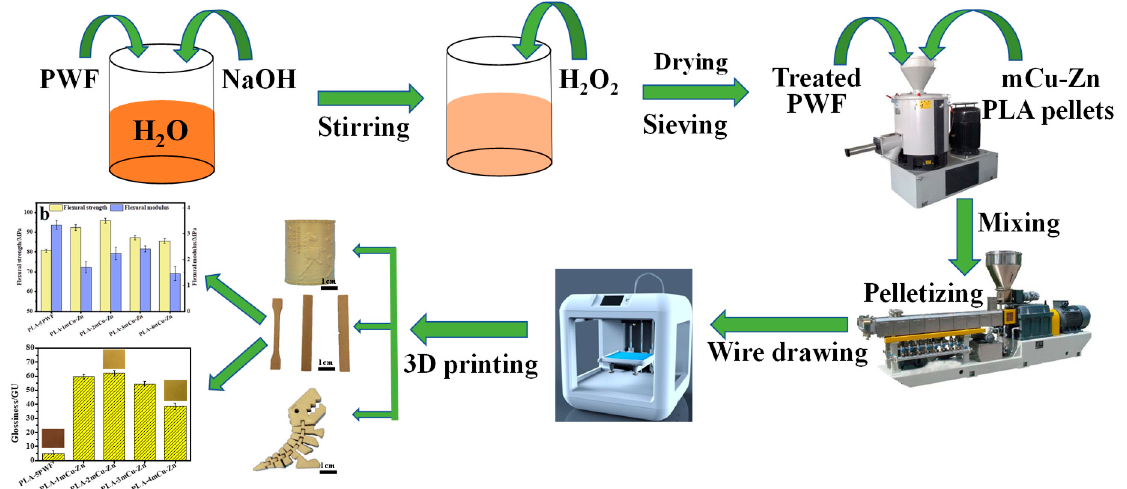
Figure 1. Flowchart showing the chemical modification of particleboard wood flour (PWF), preparation and characterization of micrometer copper-zinc alloy particles-reinforced particleboard wood flour / poly (lactic acid)(mCu-Zn / PWF / PLA) composites for 3D printing.